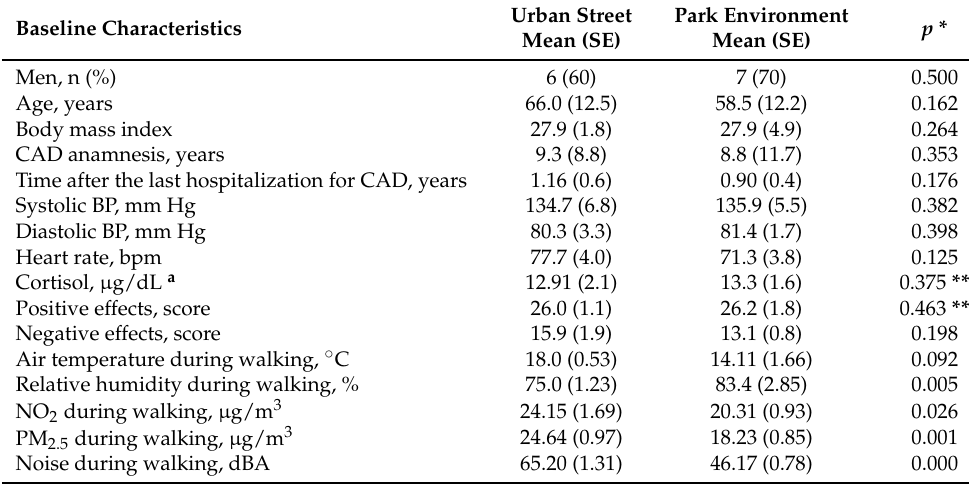
Table 1. The characteristics of the study subjects at baseline and after exposure to urban street and park environment.